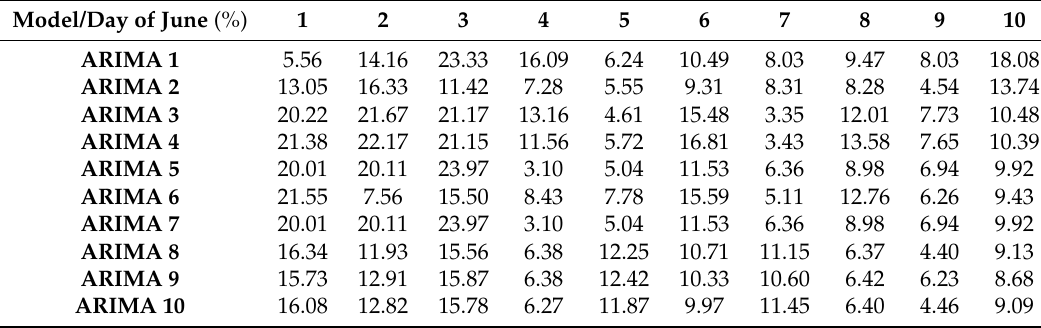
Table 4. Daily average error (%) of 1–10 June 2016, for ARIMA Models 1–10. Model/Day of June